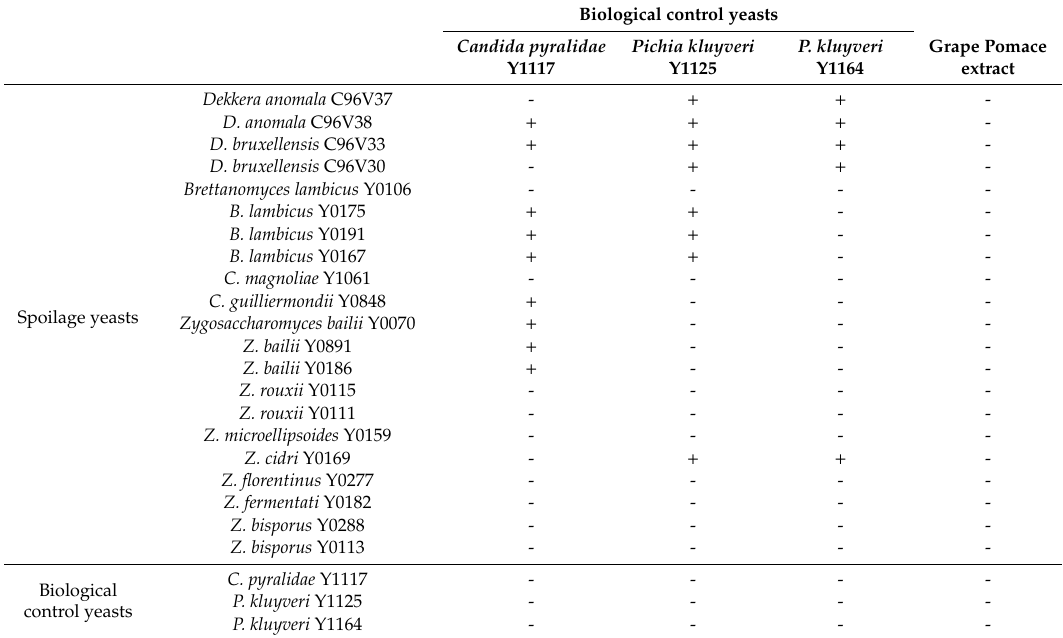
Table 1. Screening for growth inhibition activity, including the cross screening of biocontrol yeasts against each other on grape pomace extract. All yeasts used in the